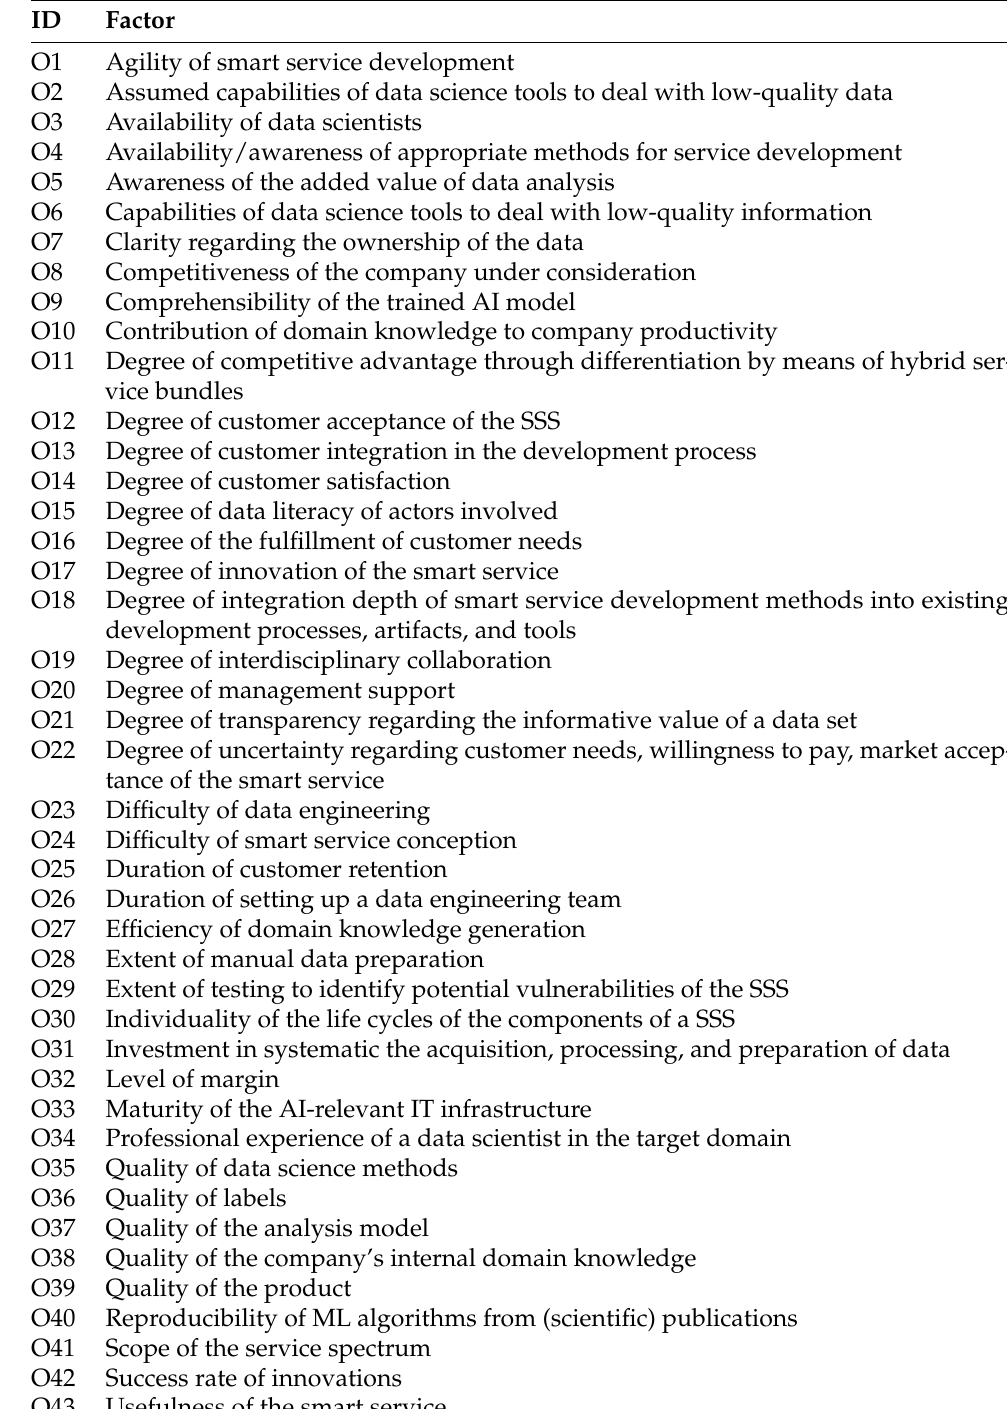
Table A1. Identified out-of-scope